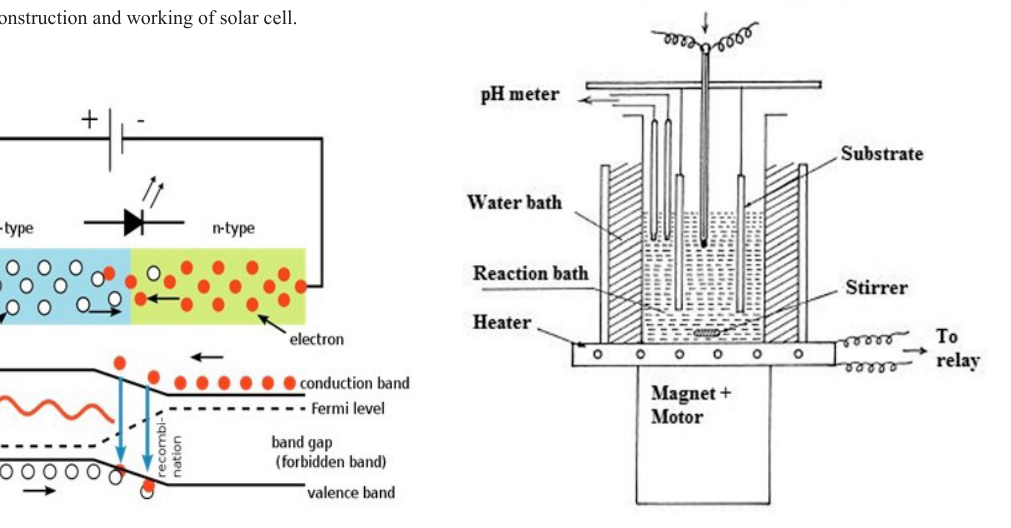
Figure 2. Formation of the p-n junction diode in the solar cell. Figure 3. Experimental setup of CBD method deposition of thin